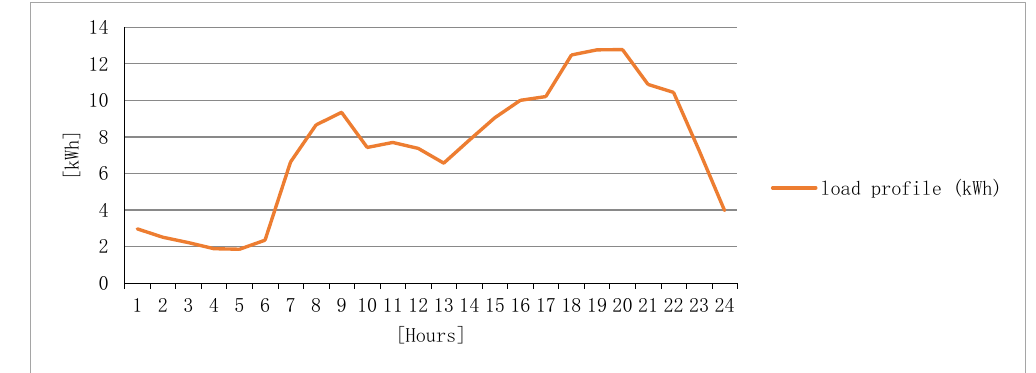
Figure 3. Mechanical ventilation, lift, lighting and appliances energy demand.